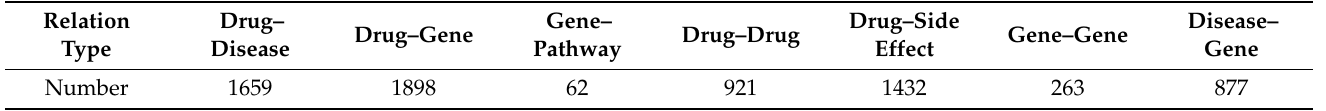
Table 1. The number of entities of each type in the KG for COVID-19.